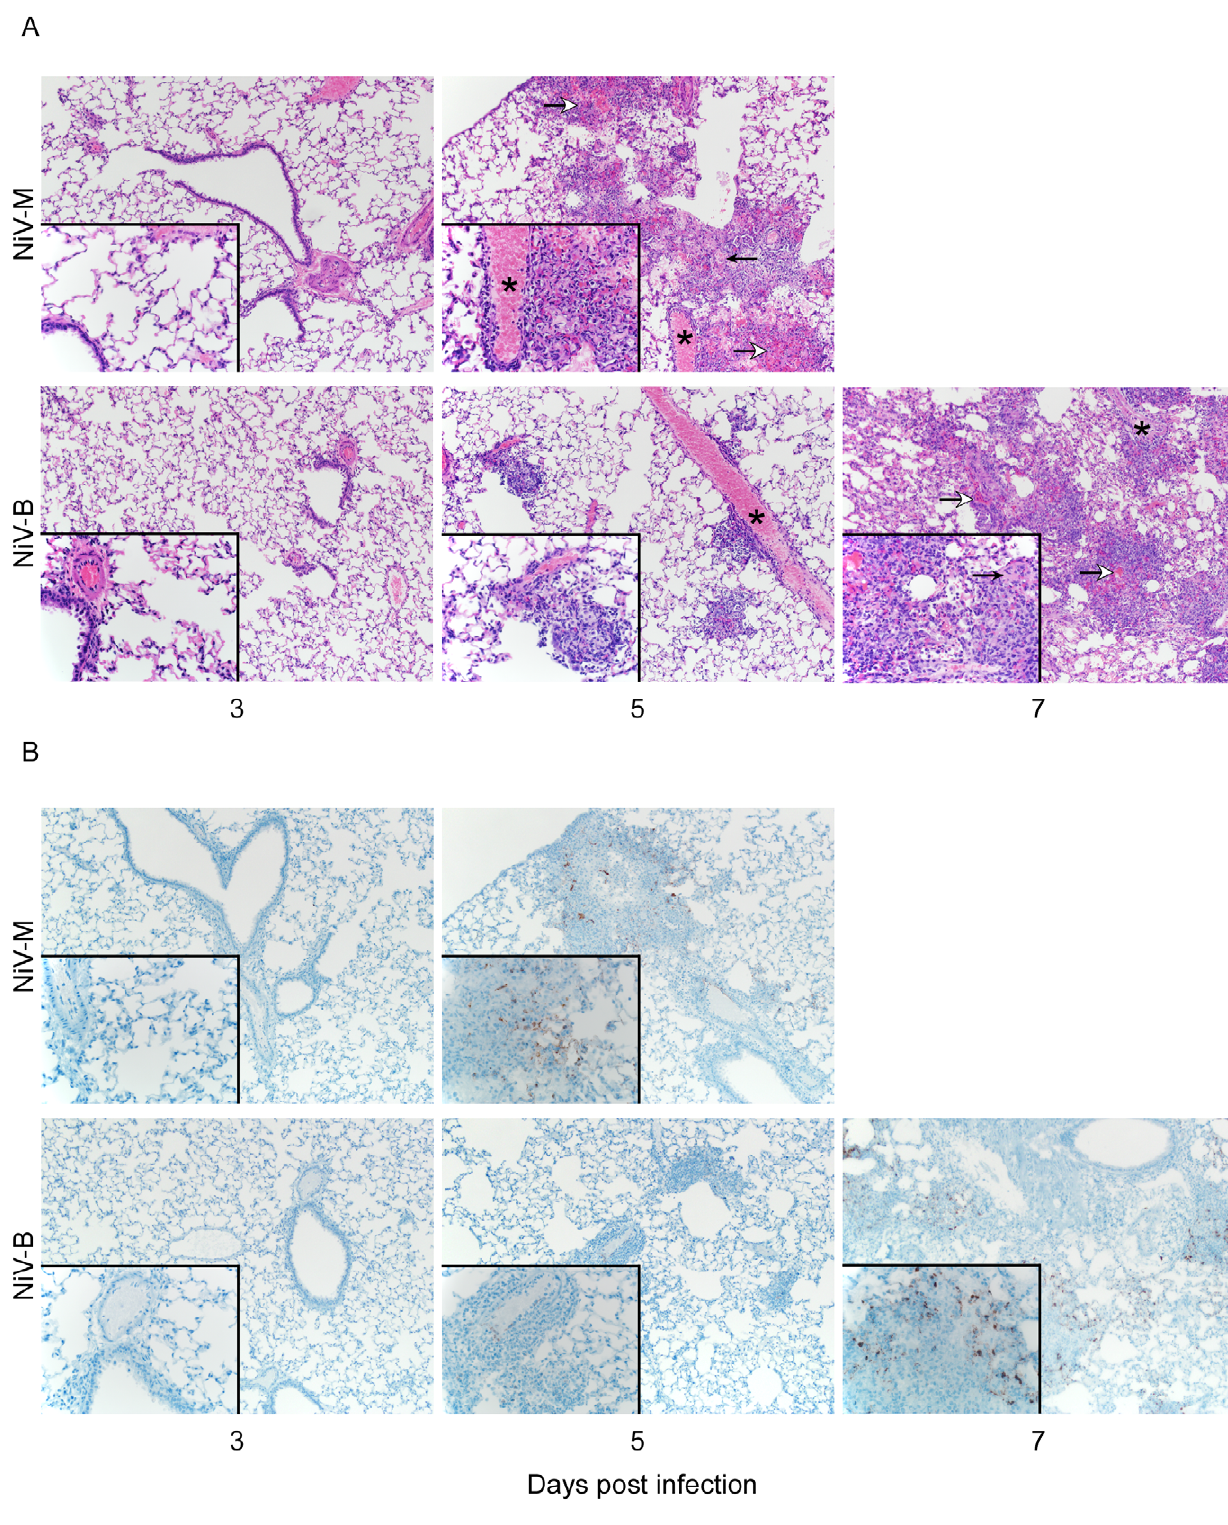
Figure 5. NiV-M infection results in accelerated pathology compared to NiV-B infection in hamsters. Nipah virus inoculated hamsters were euthanized at 3, 5 and 7 dpi (for NiV-B only) and lung sections were stained with H&E (A) and for Nipah virus nucleocapsid protein (IHC) (B) Images were taken at a magnification of 100 6 and 400 6 (insets). Asterisks denote arteries with vasculitis as demonstrated by recruitment of inflammatory cells with effacement of the tunica intima and tunica media. Open arrows denote areas of acute hemorrhage and closed arrows indicate fibrin deposits.